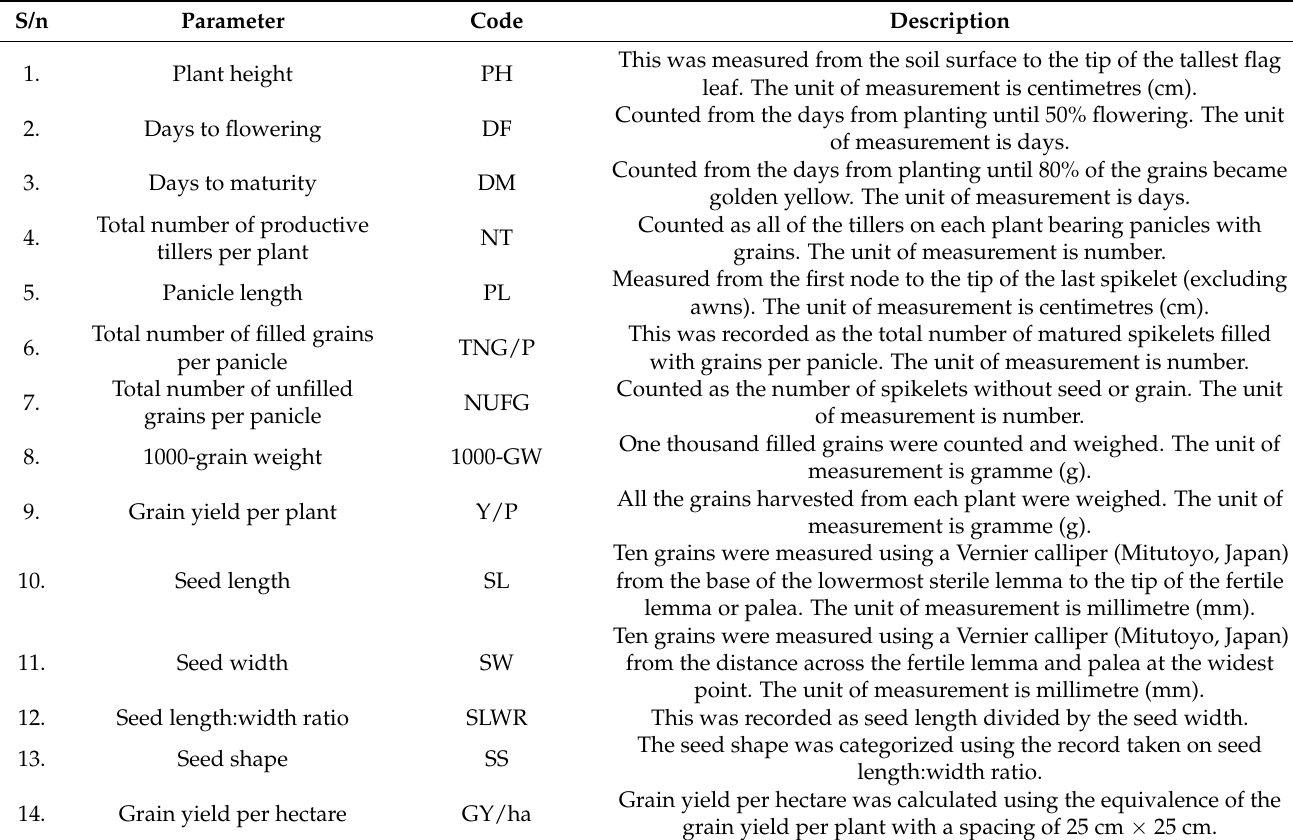
Table 2. Description of agro-morphological traits studied for phenotypic selection of improved